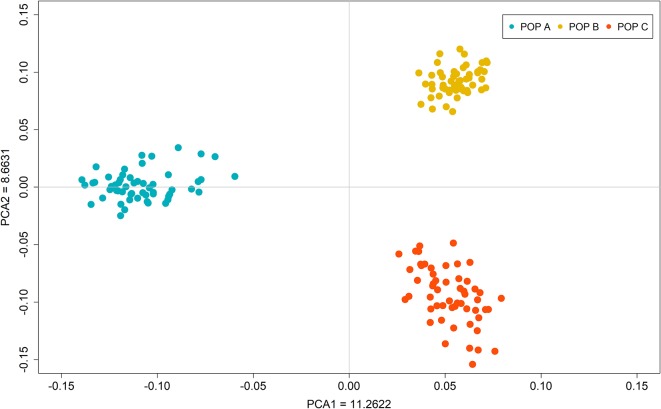
Principal component analysis of the autosomal genotypic data of three Nile tilapia population.